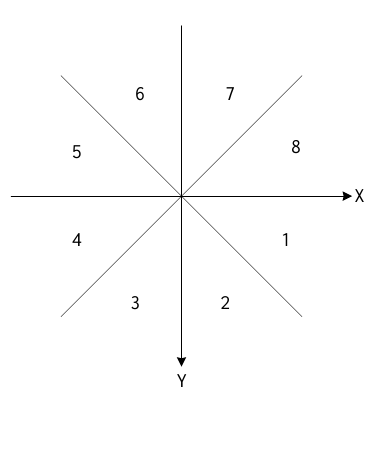
Figure 5. Categories of vector